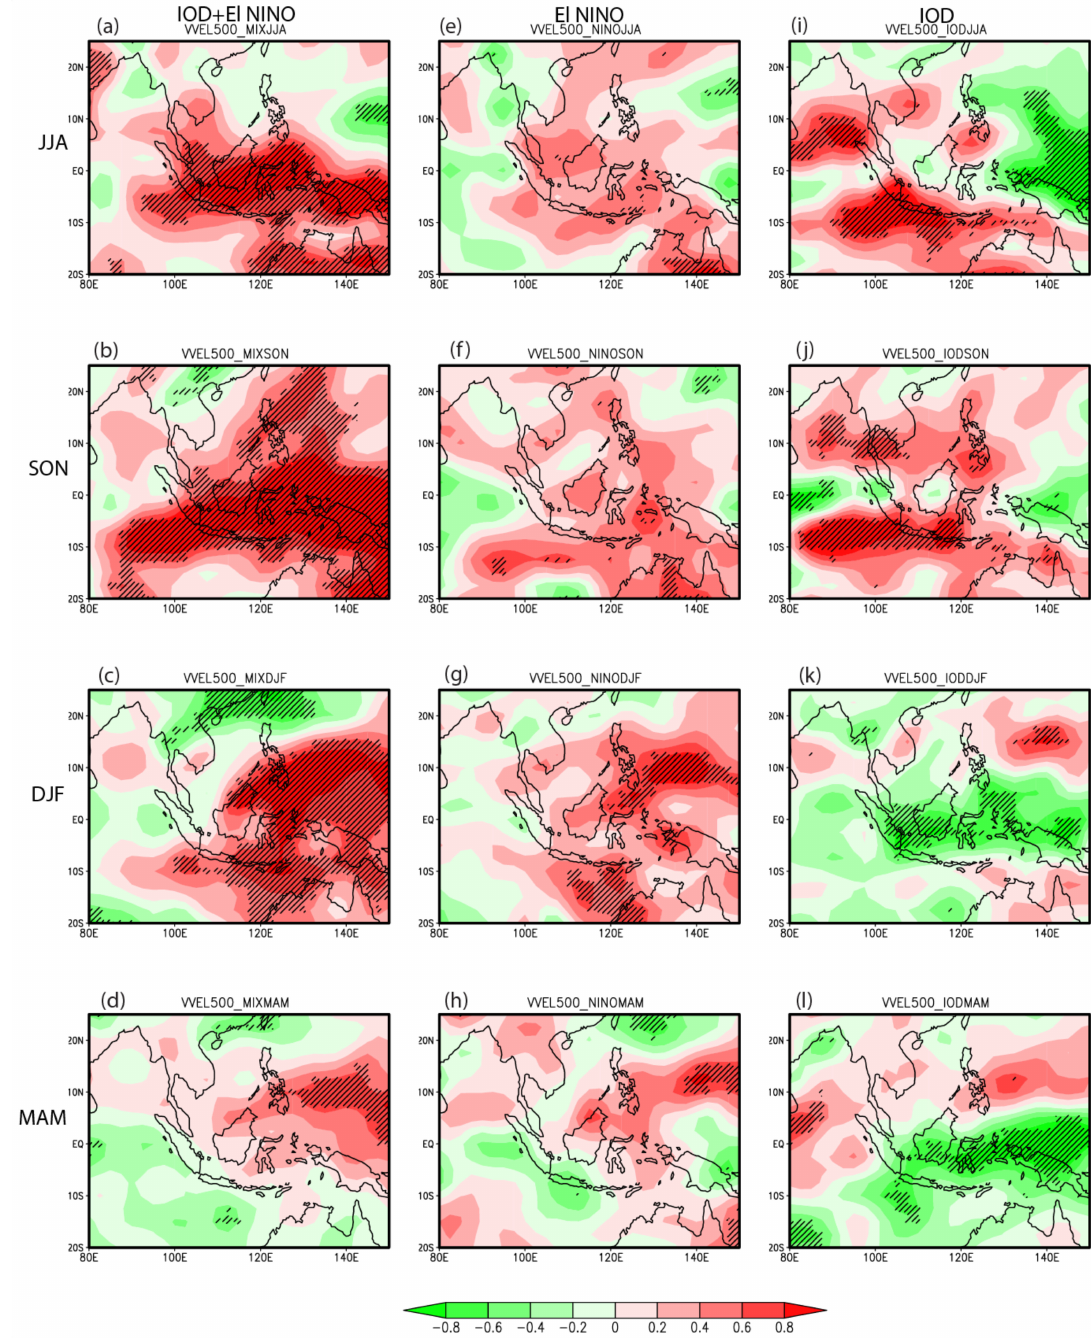
Figure 7. The composite of the vertical velocity anomaly at 500 mb for the events listed in Table 1. The hatched area indicates significance at the 95% level. ( a – d ) Co-occurrence of conventional El Niño and positive IOD, ( e – h ) pure conventional El Niño, and ( i – l ) pure positive IOD for the seasons of JJA, SON, DJF, and MAM. Unit is Pa s − 1